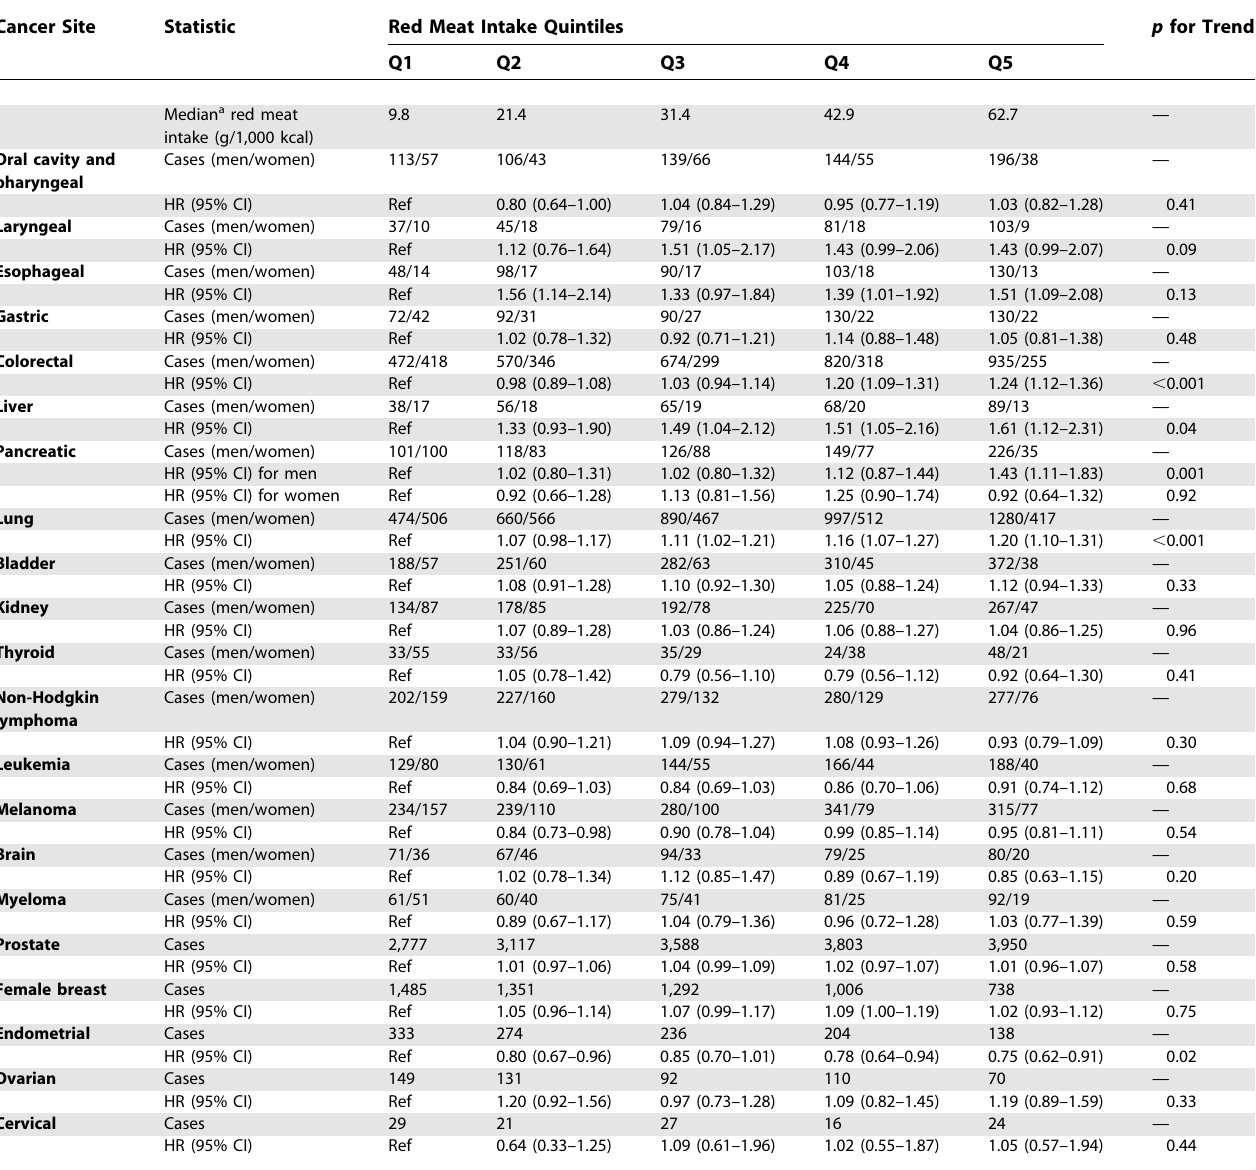
Table 2. Multivariate HRs and 95% CIs (Both Sexes Combined) for Red Meat Intake and Cancer in the NIH-AARP Diet and Health